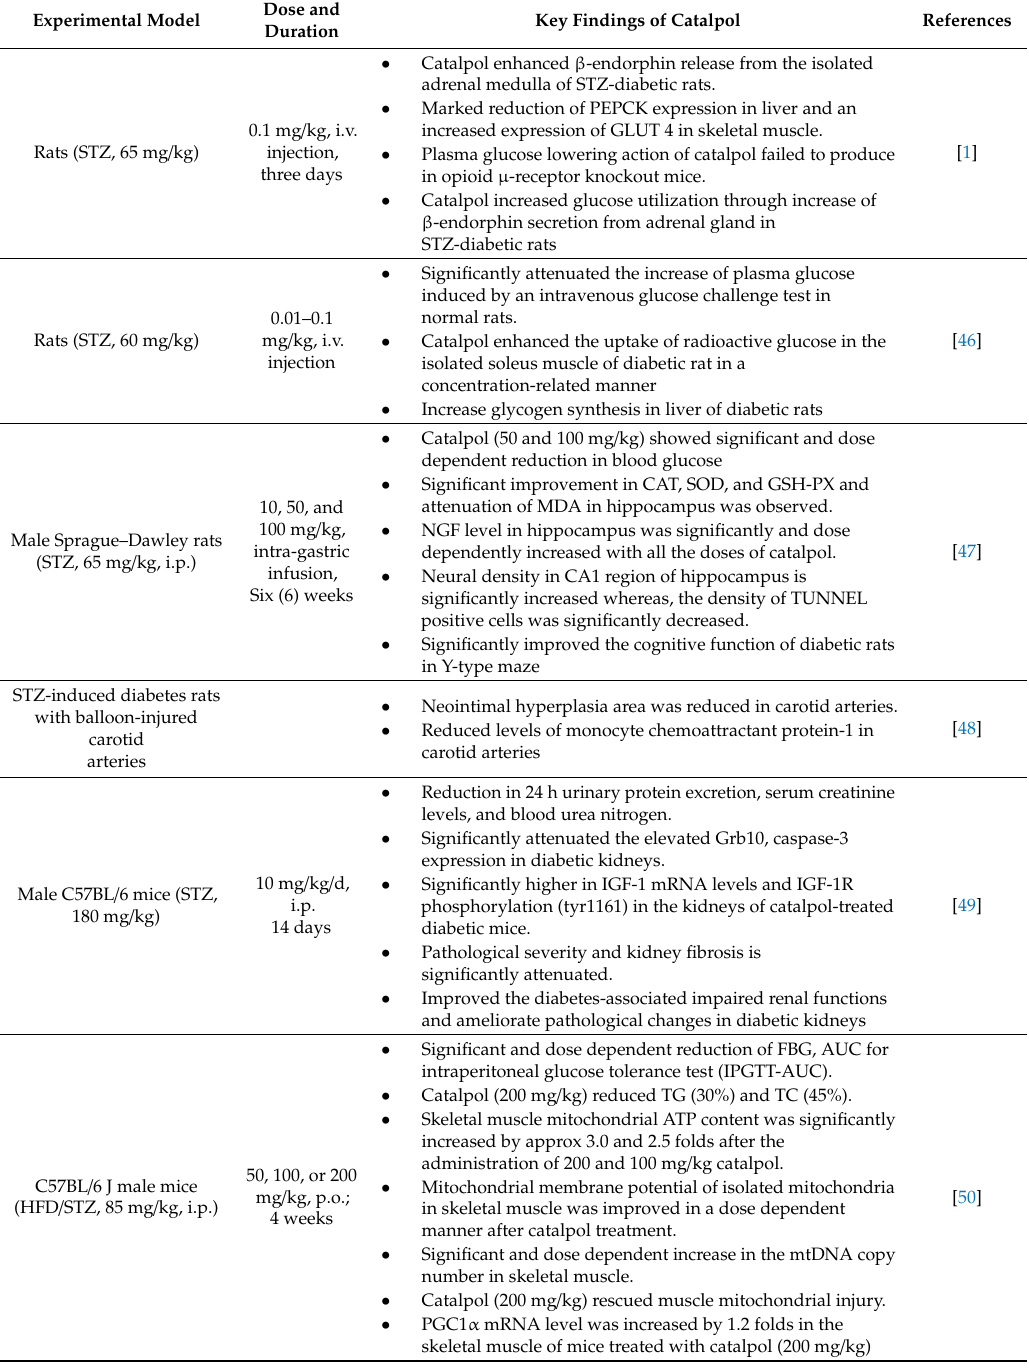
Table 3. E ff ect of catalpol in experimental models of diabetes mellitus and diabetes complications. Experimental